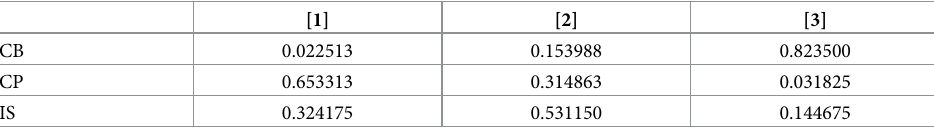
Table 6. Rank probabilities of fixation methods for IKDC score A or B.